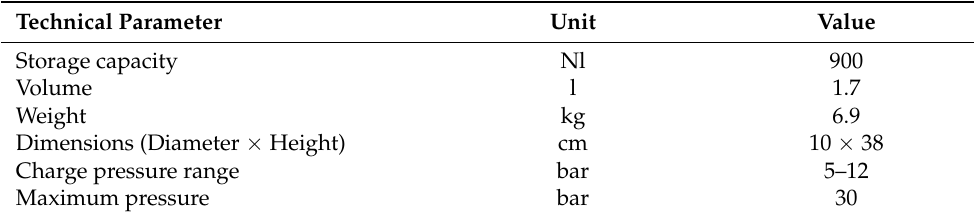
Table 2. Main MH-H2 tank technical